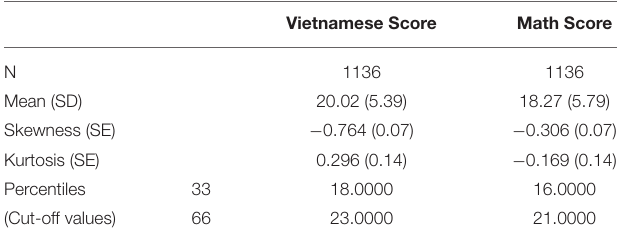
TABLE 2 | Descriptive measures of vietnamese and math